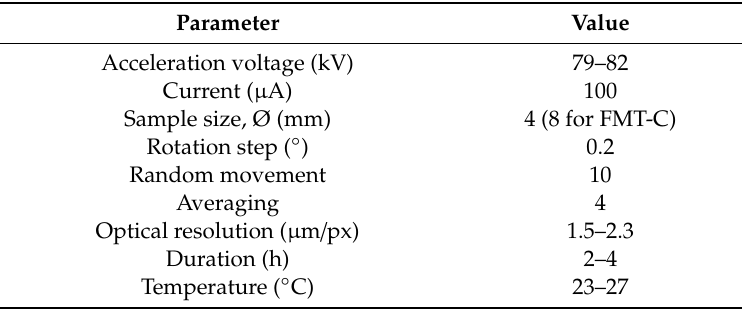
Table 2. µ -CT (micro-computer tomography) operational